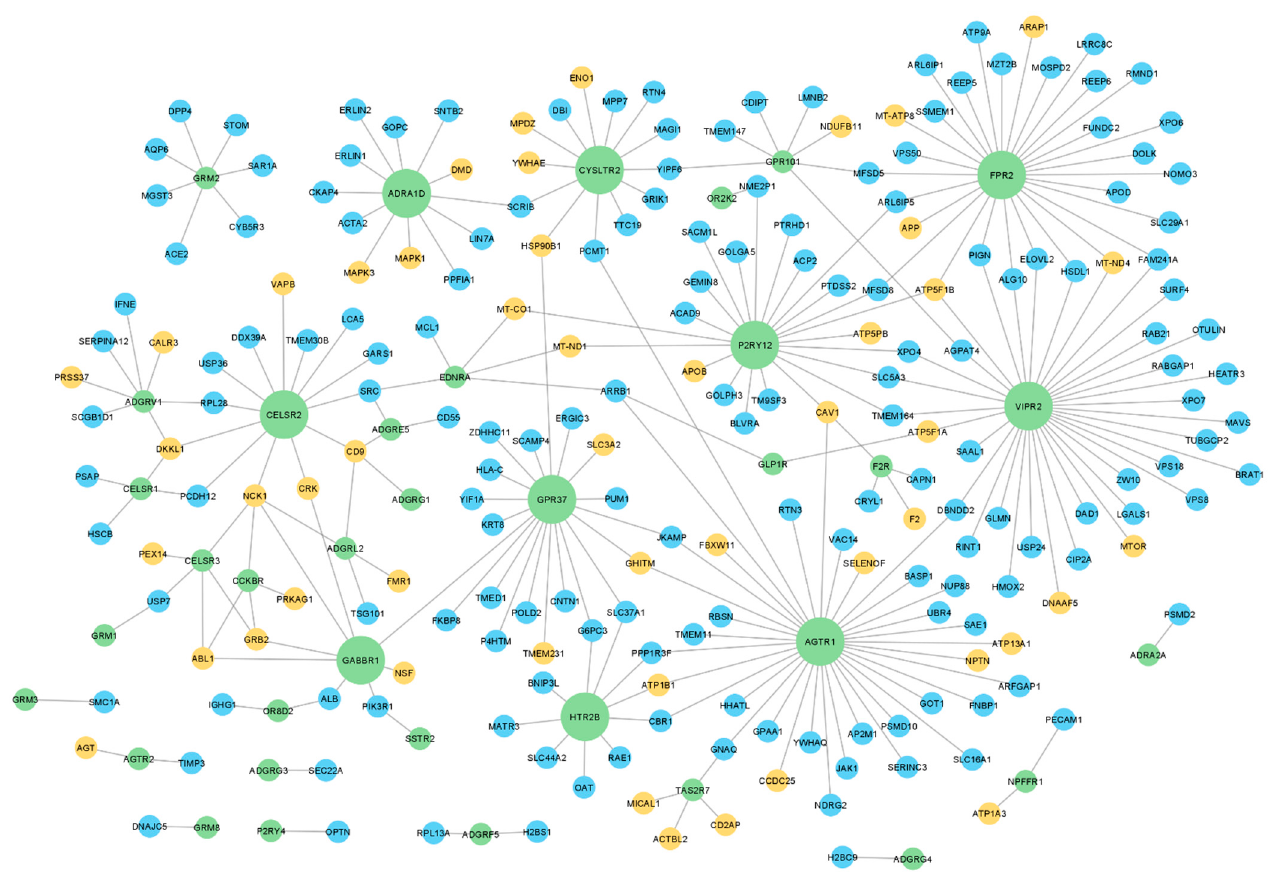
Figure 2. Protein-protein interaction network of sperm GPCRs. The green nodes represent sperm GPCRs (n = 47), the blue nodes represent their interactors (n = 163), and the orange nodes represent the interactors associated with relevant biological processes to sperm physiology (n = 49). The bigger green nodes correspond to the top 10 sperm GPCRs with a higher degree. All proteins are represented by the gene name.